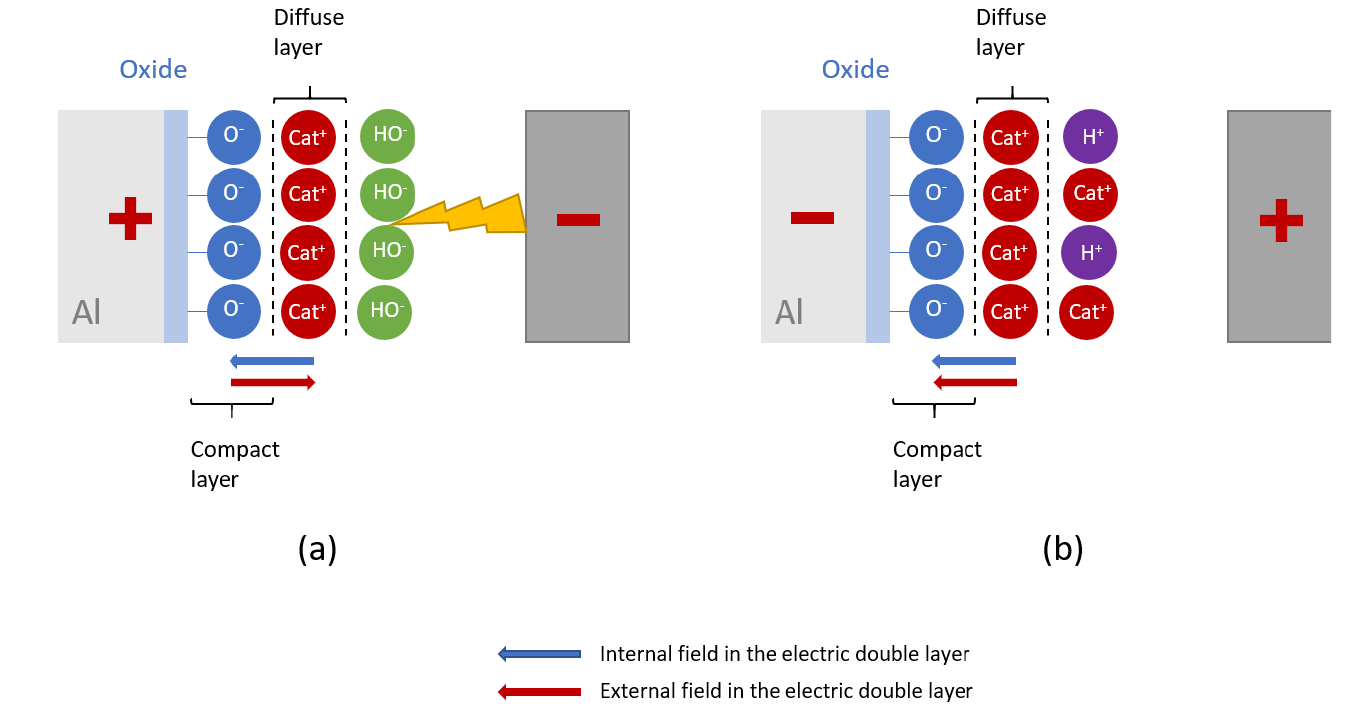
Figure 7. Schematic representation of the electrical double layer forming on the surface of an aluminium part when placed at the anode ( a ) and cathode ( b ) in an electrolyte at pH > IEP